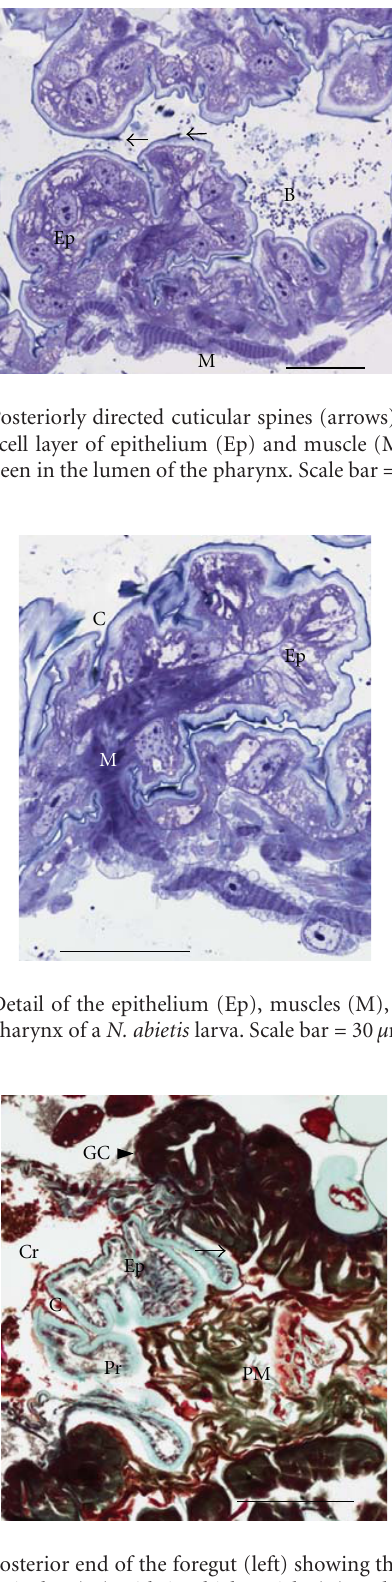
Figure 9: Posterior end of the foregut (left) showing the crop (Cr) and proventriculus (Pr) with its thick cuticle (C) and subtending epithelium (Ep) and the anterior end of the midgut (right) with a gastric caecum (GC) and peritrophic membrane (PM) being produced by cells of the cardia (arrows). Scale bar = 0.2